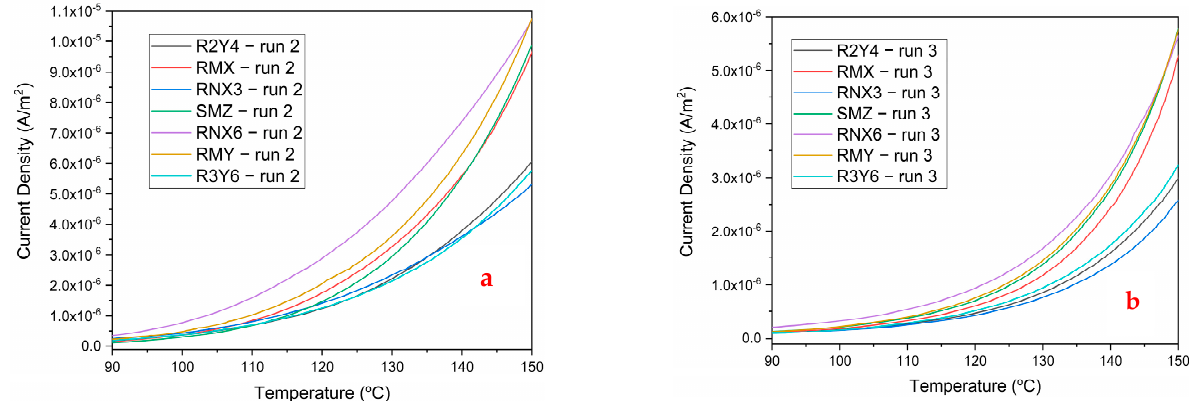
Figure 5. TSDC data from run 2 ( a ) and run 3 ( b ) of membranes R2Y4, RMX, RNX3, SMZ, RNX6, and RMY.